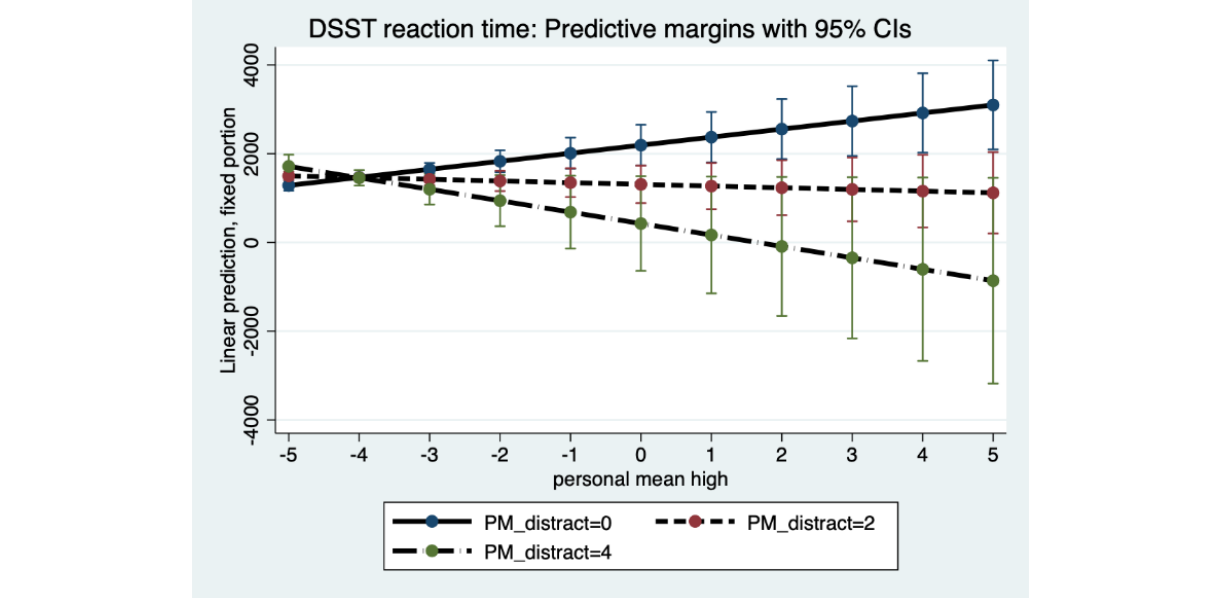
Figure 5. Digit symbol substitution task: distraction person mean (PM) as a moderator of the association between subjective high PM and reaction time. Distraction PM at low (0), moderate (2) and high levels (4). DSST: digit symbol substitution task; PM: person